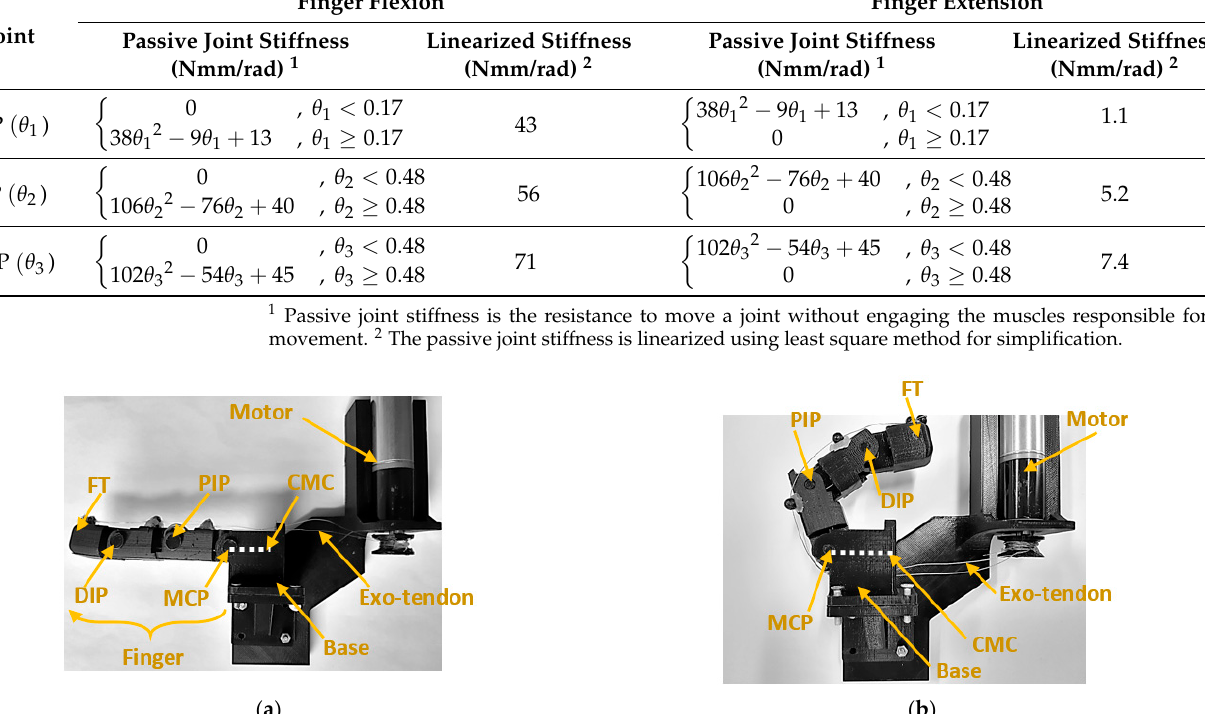
Table 1. The passive stiffness of the finger joints and its linearized stiffness for finger flexion and extension.